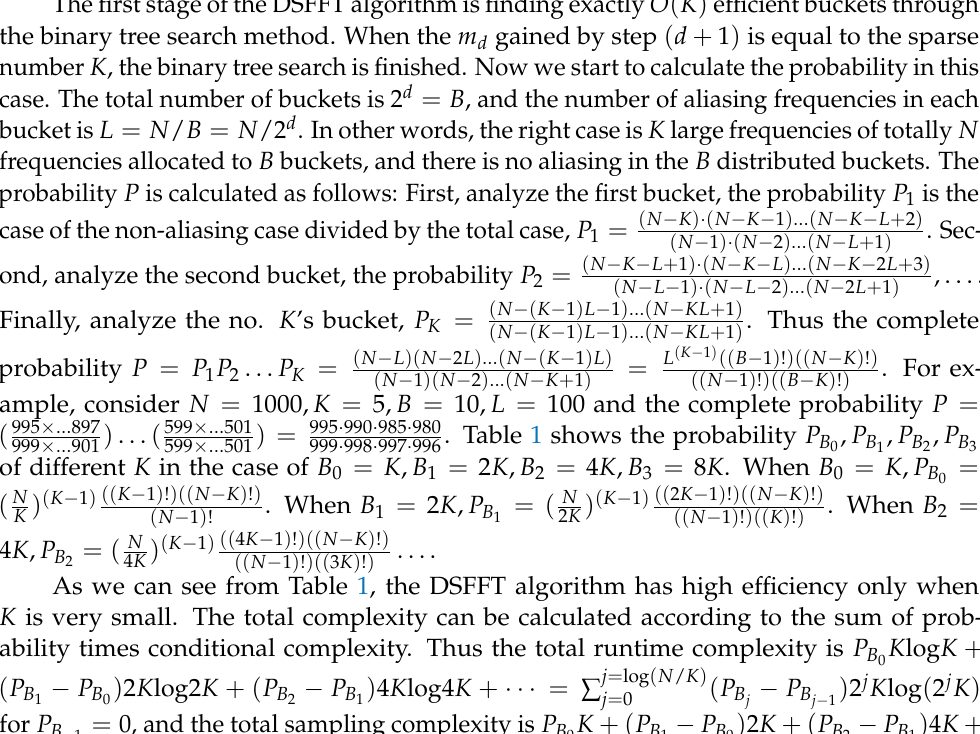
Table 1. The probability P B